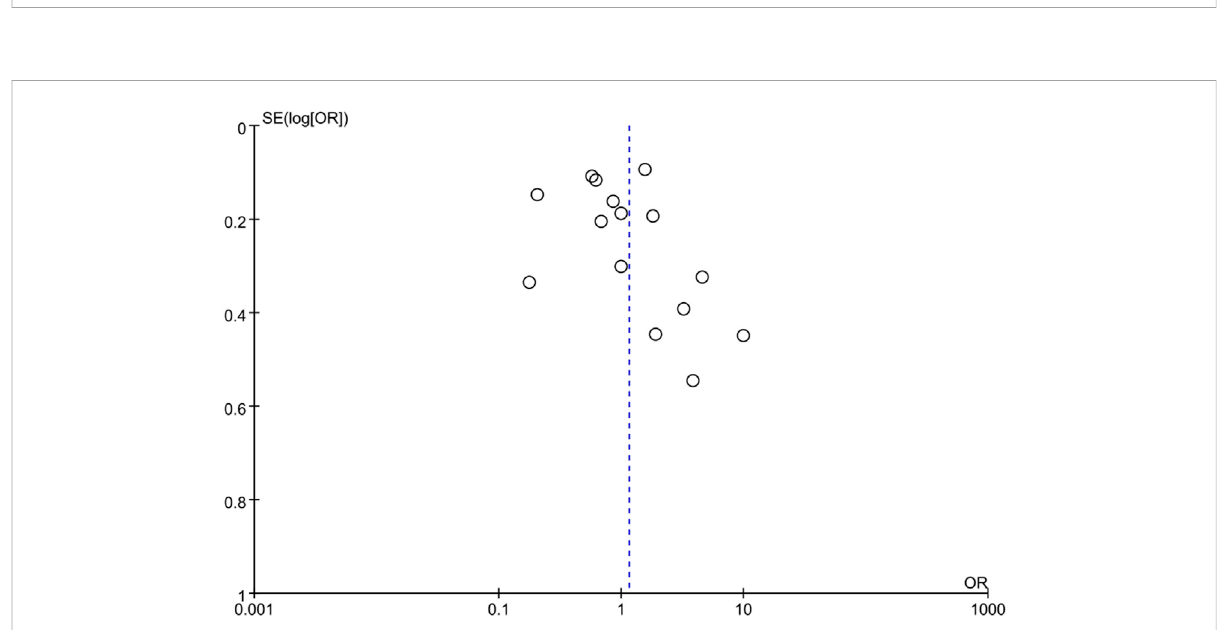
FIGURE 6 Funnel plots for meta-analysis of association between non-alcoholic fatty liver disease and the risk of diabetic retinopathy in diabetes mellitus.